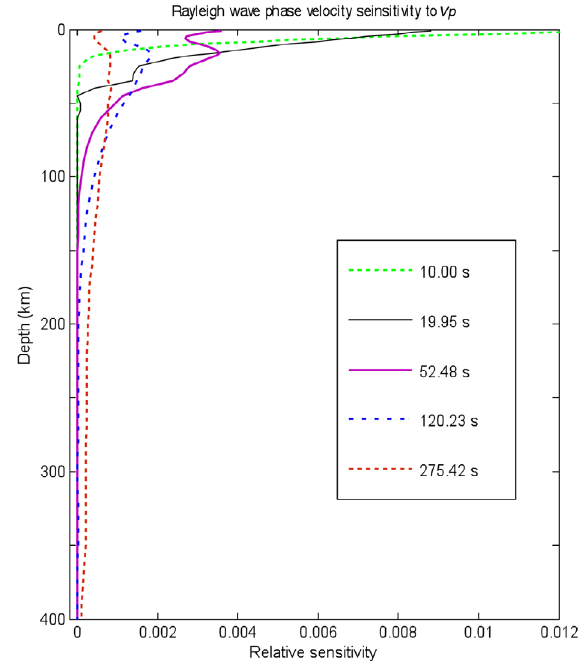
Figure 5. Relative sensitivity of phase velocity ( c ) of Rayleigh waves to S -wave velocity ( Vs ) versus depth of the accepted model (Table 5) at various representative periods. The sensitivity shows partial de- rivatives ∂ c / ∂ Vs in a layer of 1 km centered at the given depth.